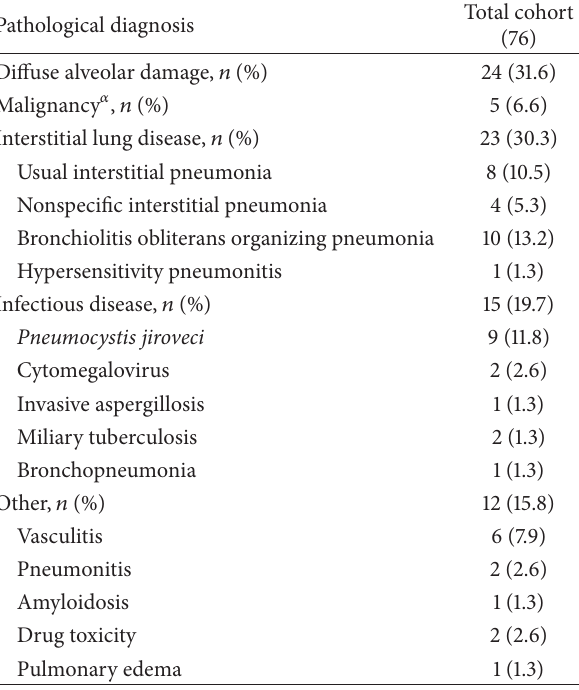
Table 2: Pathological results of open lung biopsy